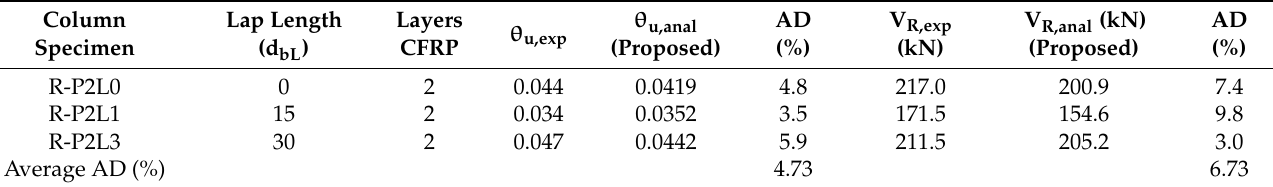
Table 3. Comparison of analytical and experimental values of θ u and V R